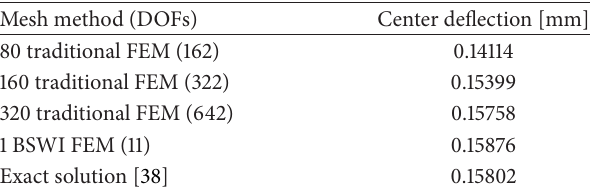
Figure 11: Time consumption comparison of center deflection for the simply supported Mindlin plate under uniform load stochastic analysis. Table 1: Comparison of center deflection of clamp supported beam under uniform load.